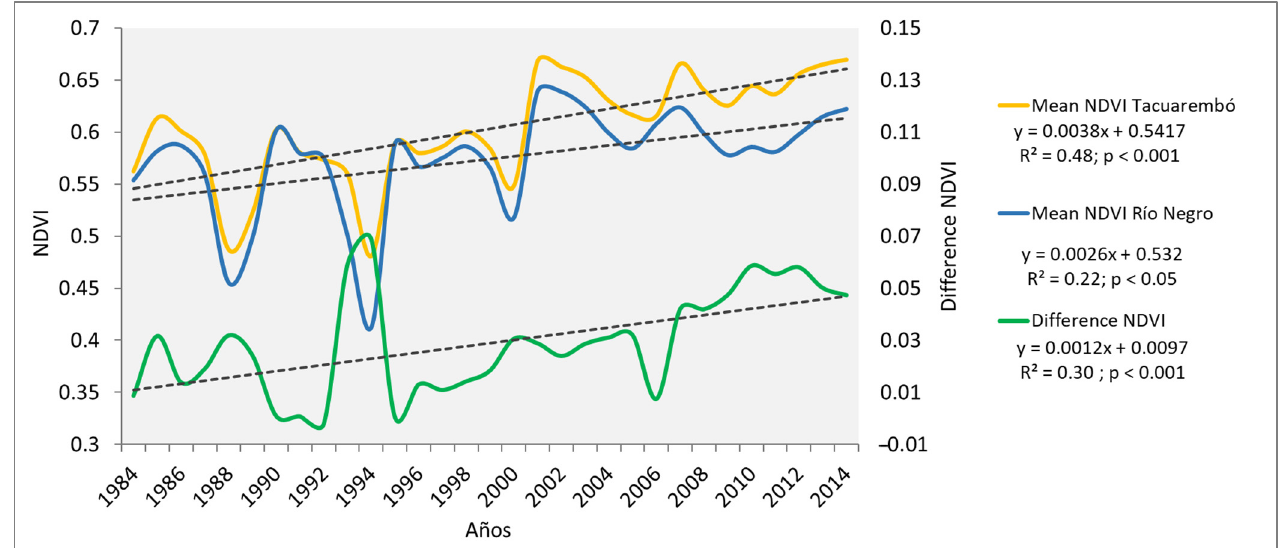
Figure 6. Time series trend analysis (1984–2014) of annual averages of maximum monthly values of the NDVI index and the difference between the two basins. The yellow line corresponds to the annual averages of the NDVI index of the Tacuarembó basin. The blue line corresponds to the annual averages of the NDVI index of the Río Negro basin. The green line corresponds to the difference between the annual average values of the NDVI index of both basins. Dashed black lines correspond to the trend of each time series.